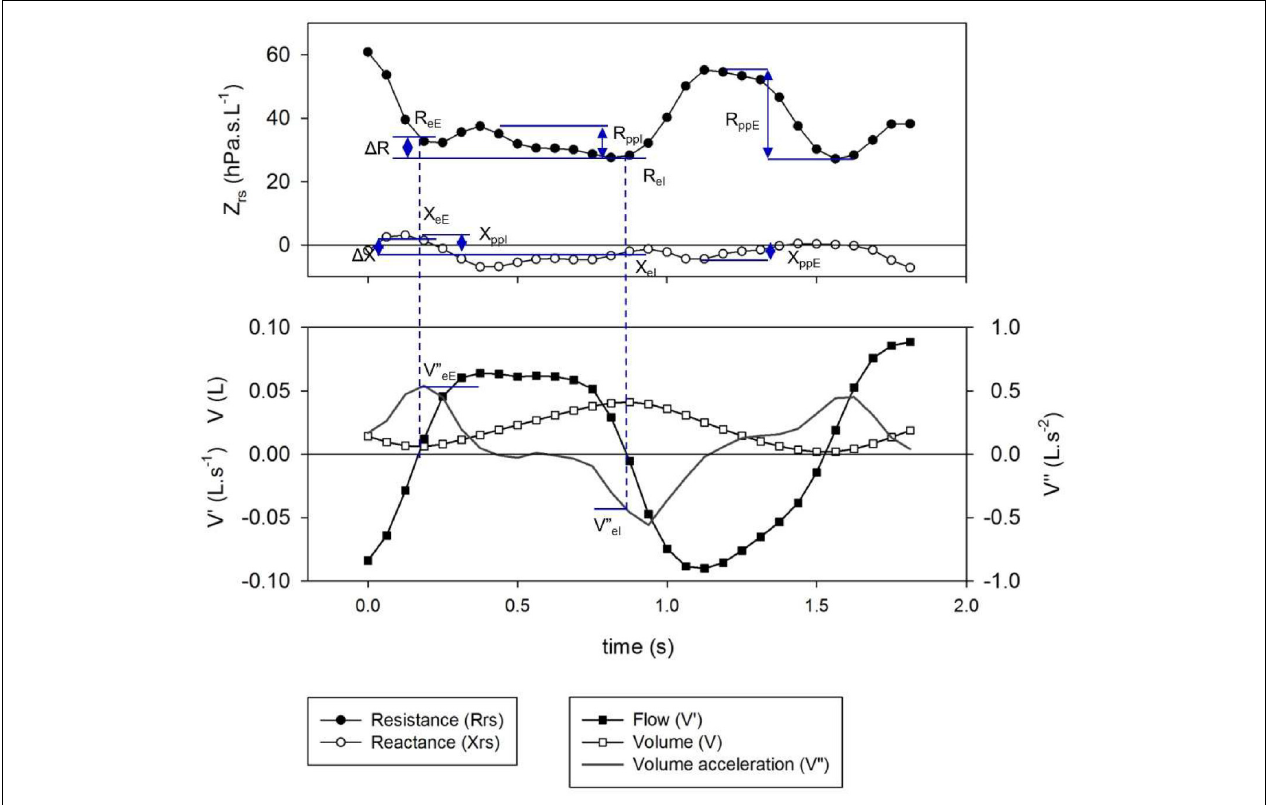
FIGURE 1 | Definition of specific intra-breath measures of resistance (Rrs) and reactance (Xrs). Shown are the time points of end inspiration (eI)- and end expiration (eE) (indicated by dotted lines), their differences ( (cid:49) ) and peak-to-peak changes in inspiration (ppI) and expiration